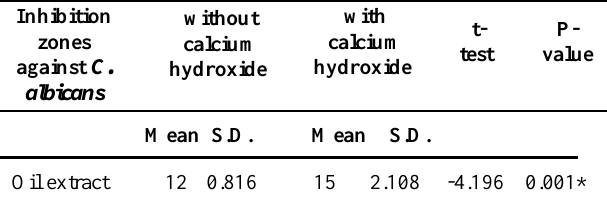
Table 4: Comparison between the antifungal activity of oil extract with and without calcium hydroxide against Candida albicans . Inhibition with without t- P- zones calcium calcium test value against C. hydroxide hydroxide albicans Mean S.D. Mean S.D. Oil extract 12 0.816 15 2.108 -4.196 0.001* [*] Highly significant